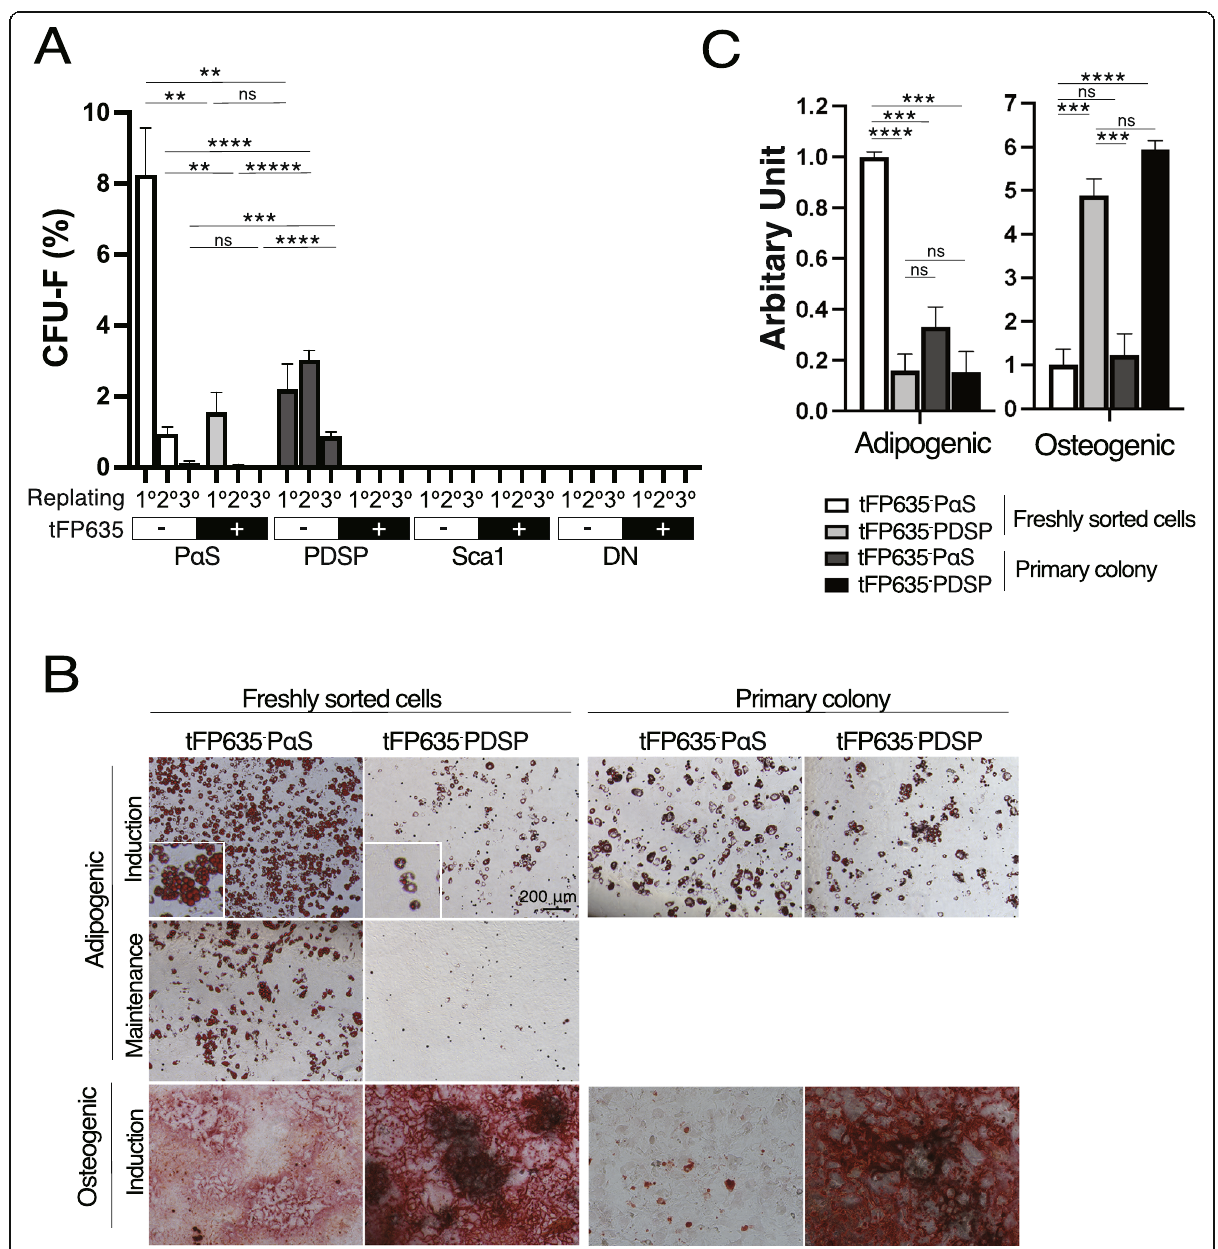
Fig. 5 tFP635 - PDSP retain secondary colony-forming activity. A Number of CFU-Fs 14 days after plating. Data are shown as the mean ± SEM ( n = 3). * P < .05; ** P < .01; *** P < .005; **** P < .0005; ***** P < .00005 by the Student ’ s t test. B Differentiation capacities of freshly sorted tFP635 - P α S, tFP635 - PDSP, and cells consisting of tFP635 - P α S- or tFP635 - PDSP-derived primary colonies (primary colony). C Quantification of Oil Red O (Adipogenic) and Alizarin Red (Osteogenic)